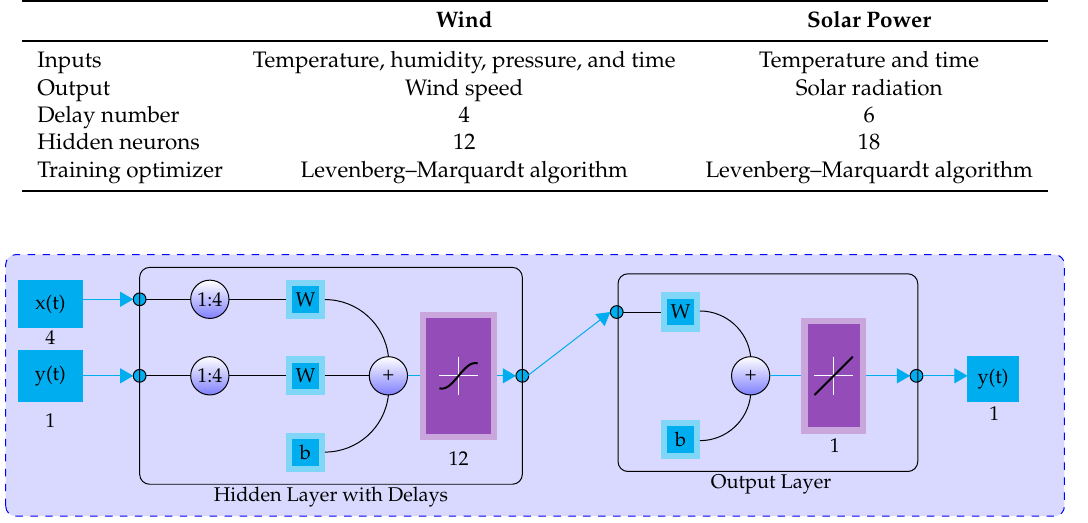
Figure 4. Artificial neural network (ANN) scheme for wind speed prediction